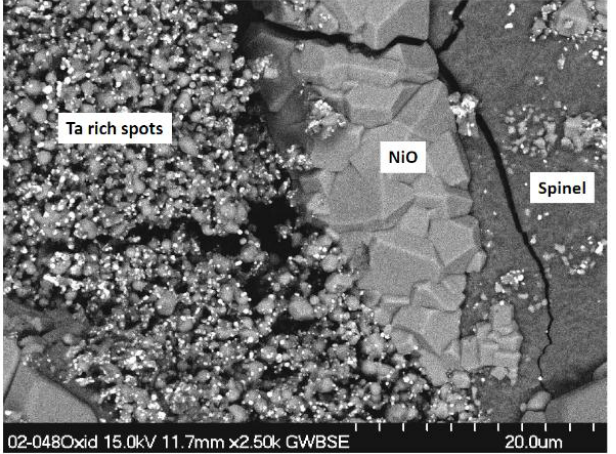
Figure 4. Representative alloy surface scale microstructures remaining on a high Mo alloy 2-48: (0010) after 200 h cyclic oxidation at 1100 °C. Features for NiO, NiAl 2 O 4 , and NiTa 2 O 6 are